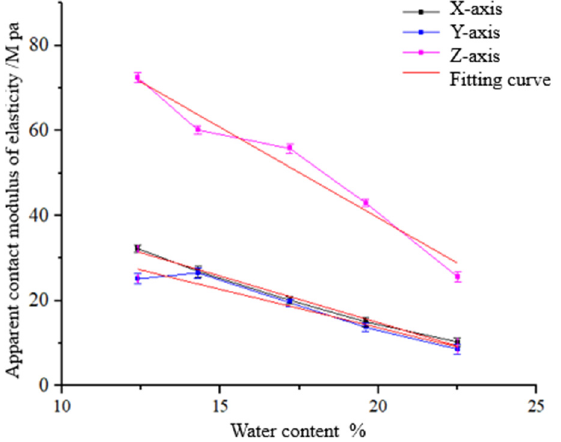
Figure 10. Triaxial modulus of elasticity of sorghum seeds.